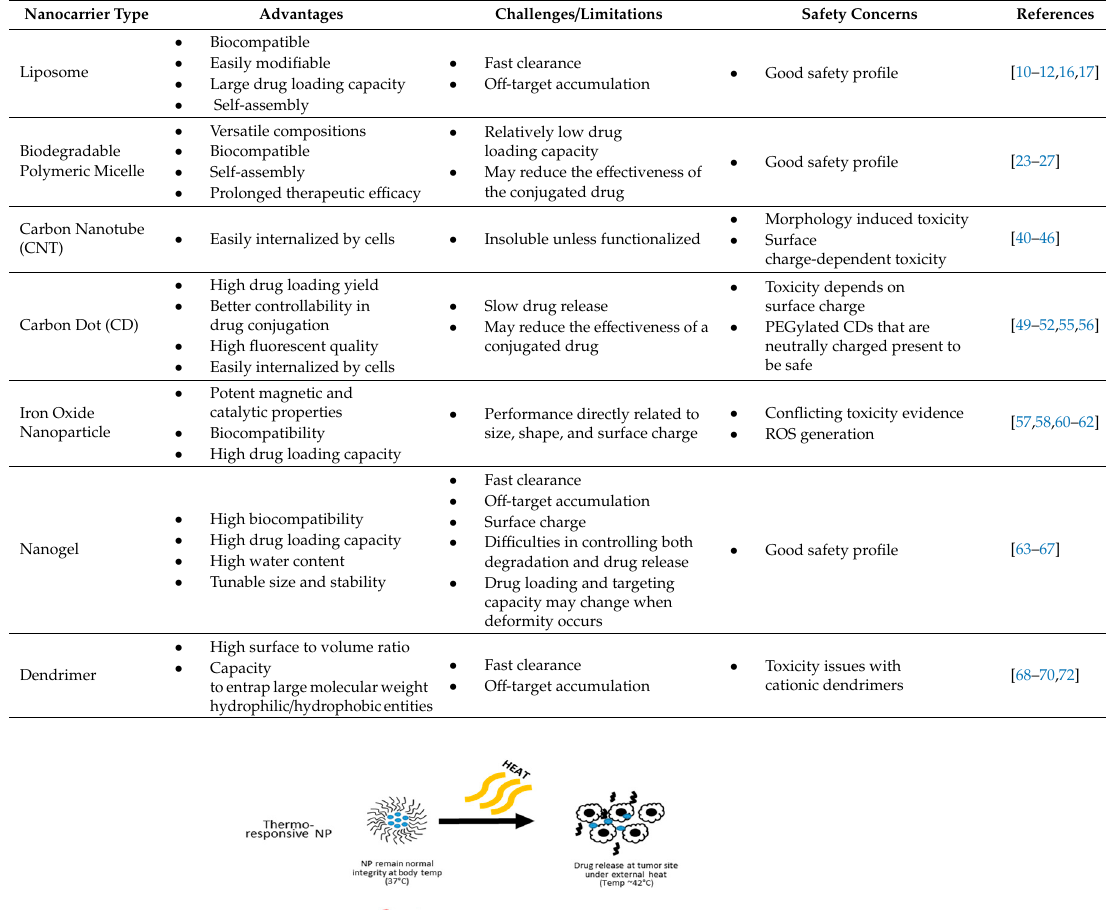
Table 1. Features of di ff erent types of nanocarriers.